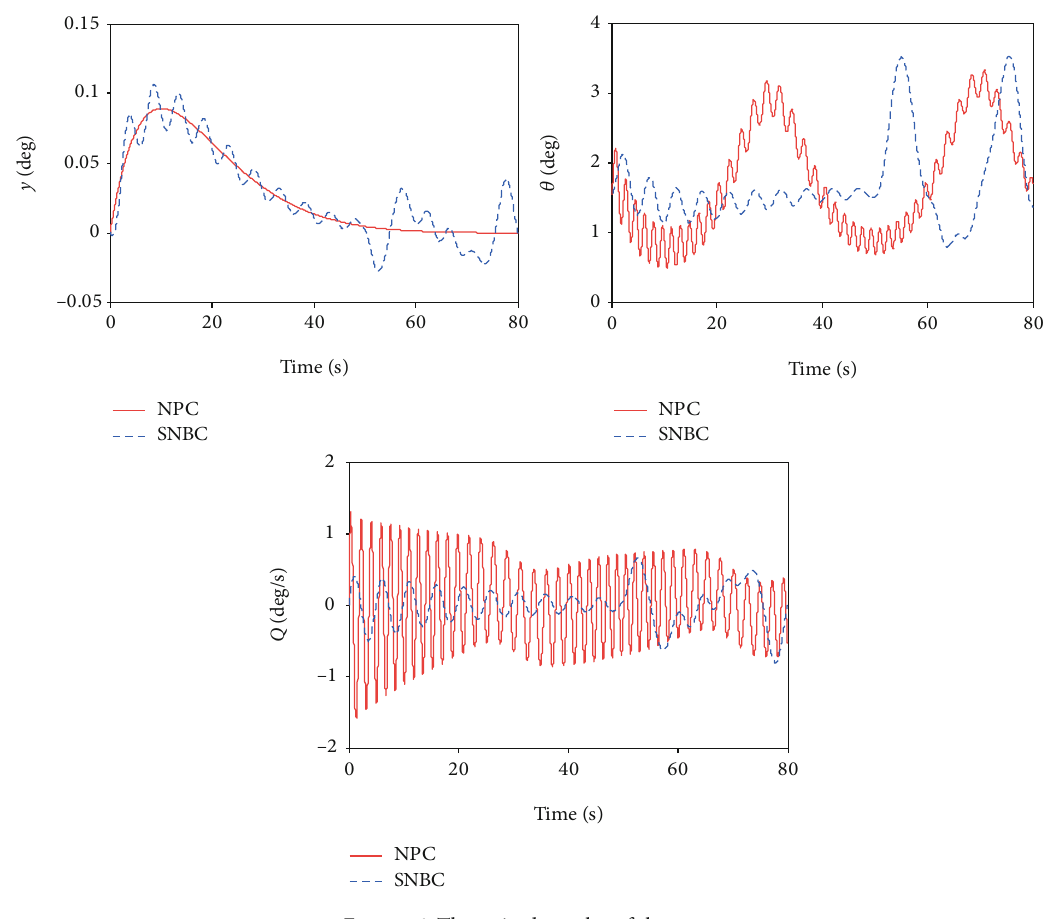
Figure 6: The attitude angles of the